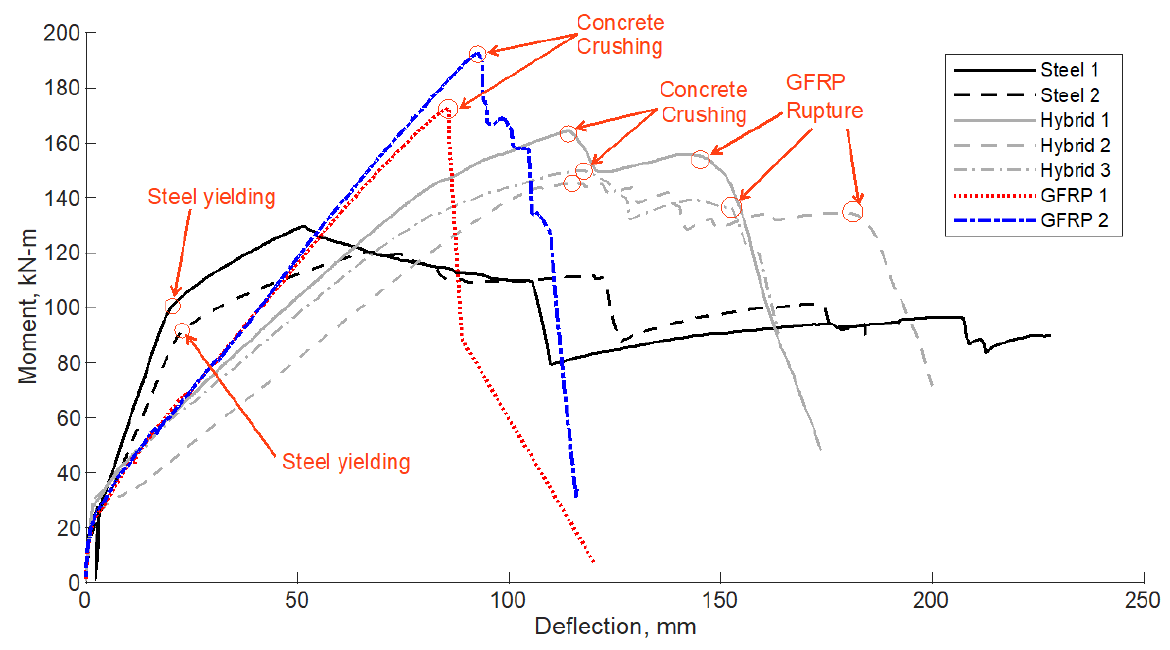
Figure 5. Moment-deflection relationships of specimens tested under static load.